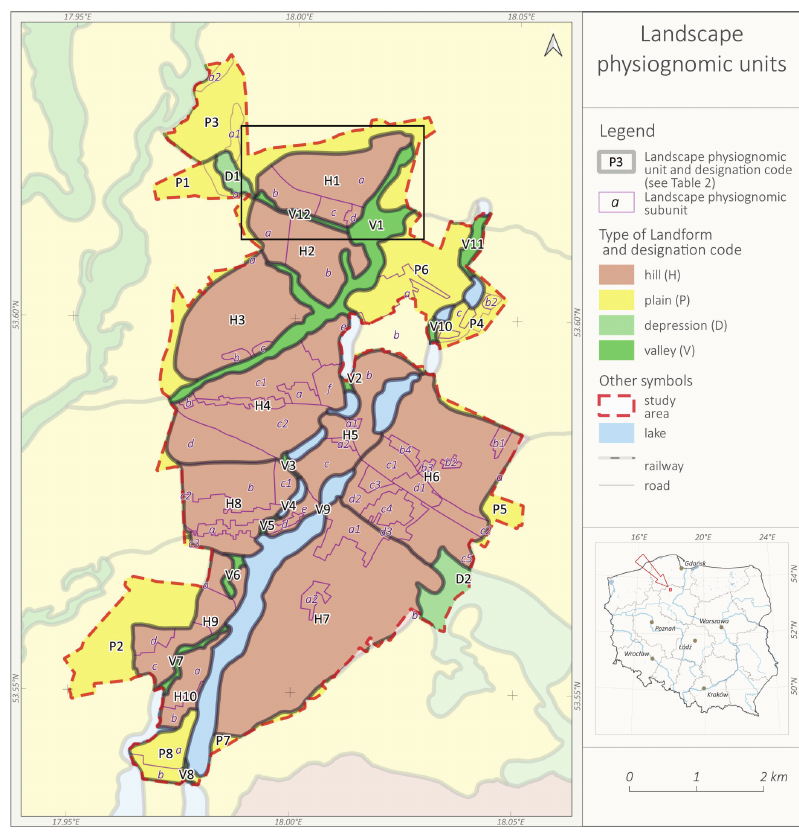
Figure 6. LPUs and subunits. The area selected for a detailed description (marked with the rectangle).